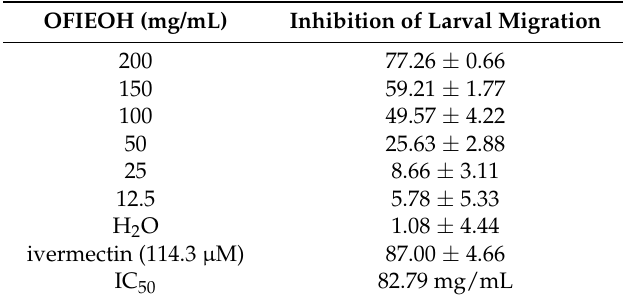
Table 3. Percentage ( ± standard deviation) of inhibition of larval migration of gastrointestinal nematodes in the larval migration test in the presence of Opuntia ficus-indica essential oil (OFIEOH) from cladode peels. The IC 50 was based on the extract calculations and ivermectin was used as positive